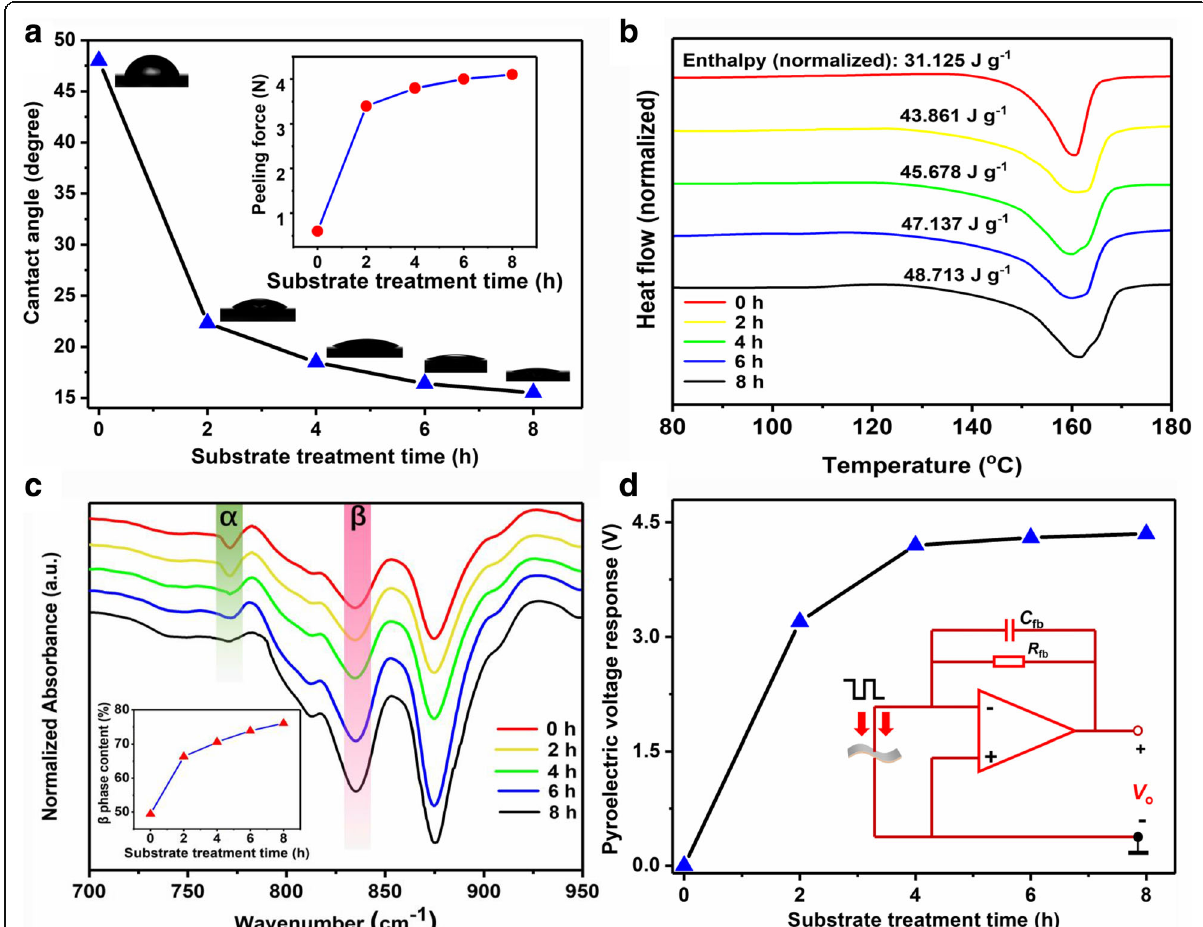
of PVDF samples. c FTIR spectra of PVDF samples, inset is β -phase content as a function of treatment time calculated from the FTIR results. d Pyroelectric response of PVDF samples without undergoing thermal poling, inset is the simplified schematics of homemade signal readout